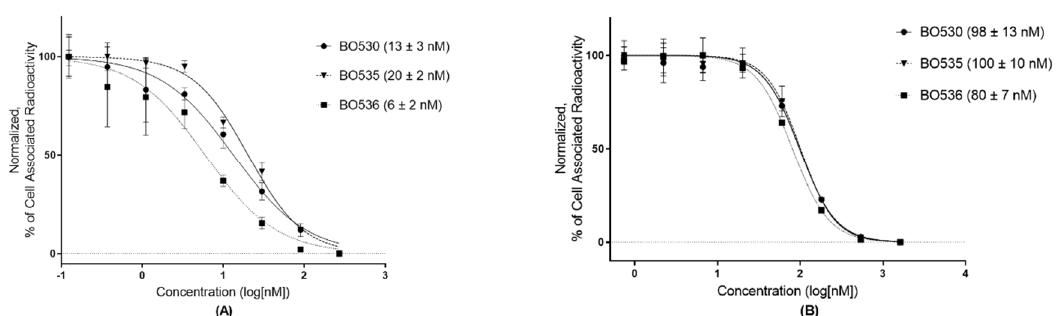
Figure 4. Binding inhibition of [ 111 In]In-NOTA-PEG 4 -RM26 ( A ) and [ 111 In]In-PSMA-617 ( B ) with BO530, BO535, and BO536 tested using PC-3 ( A ) and PC-3pip, GRPRs were blocked with 200 nM of unlabeled RM26 ( B ). Data are presented as mean value ± standard deviation.